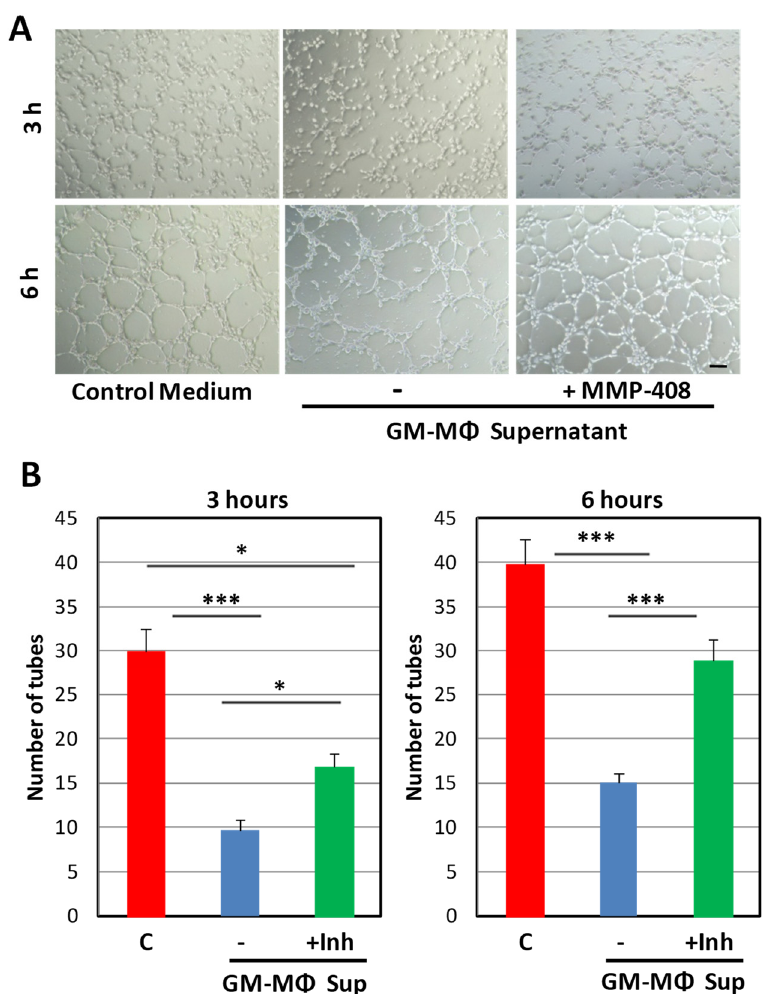
Figure 3. E ff ect of GM-M Φ supernatants on endothelial tubulogenesis in the presence of the MMP-12 inhibitor. HUVECs were incubated on Matrigel plates, as described in Figure 1, but in the absence ( − ) or presence ( + Inh) of the MMP-12 inhibitor MMP-408, as indicated. Addition of MMP-408 significantly rescued the tubulogenesis inhibition induced by GM-M Φ supernatants. The cord network formation was visualized, and representative assays of more than three di ff erent experiments per condition ( n = 6) are shown ( A ). Scale bar: 100 µ m. The number of closed tubes in the network was quantified and represented by histograms ( B ). Statistical significance was calculated using one way ANOVA, and data are presented as mean ± SEM. (* p < 0.05; *** p <